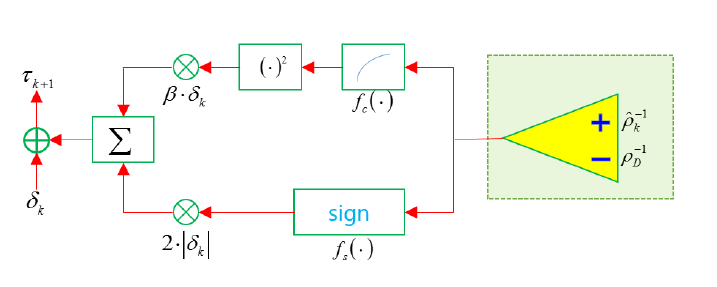
Figure 1. Extremum seeking control structure for adjusting the detection